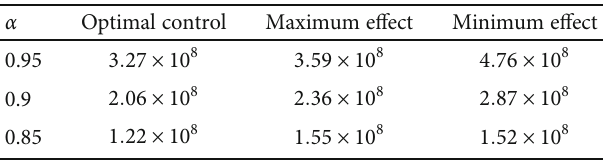
Figure 2: Optimal control Strategy 1 with ETV monotherapy and α = 0 : 95, 0 : 9, 0 : 85 . Table 2: The corresponding number of objective function of Strategy 1 with di ff erent order and control